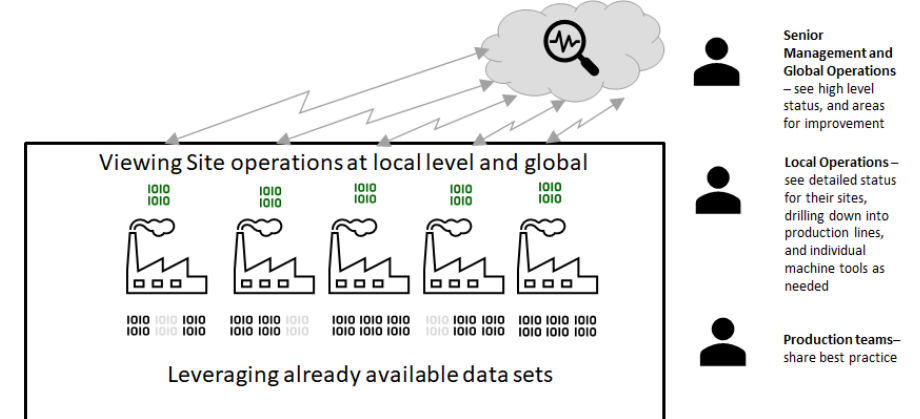
Fig. 3. Multiple actors and multiple sites